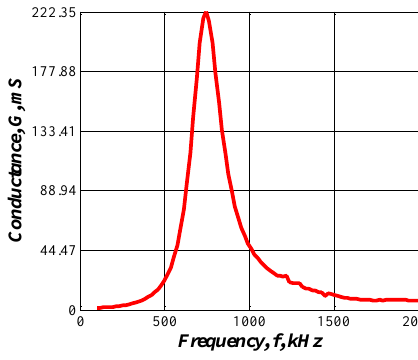
Figure 4. Resonant frequency.